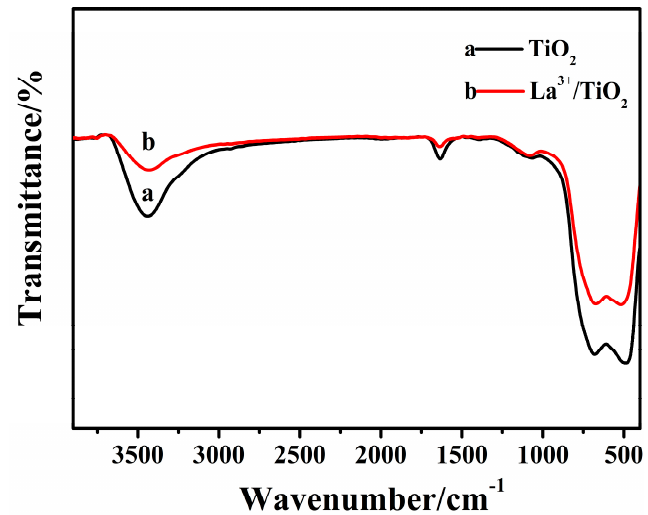
3+ /TiO 2 and La 2